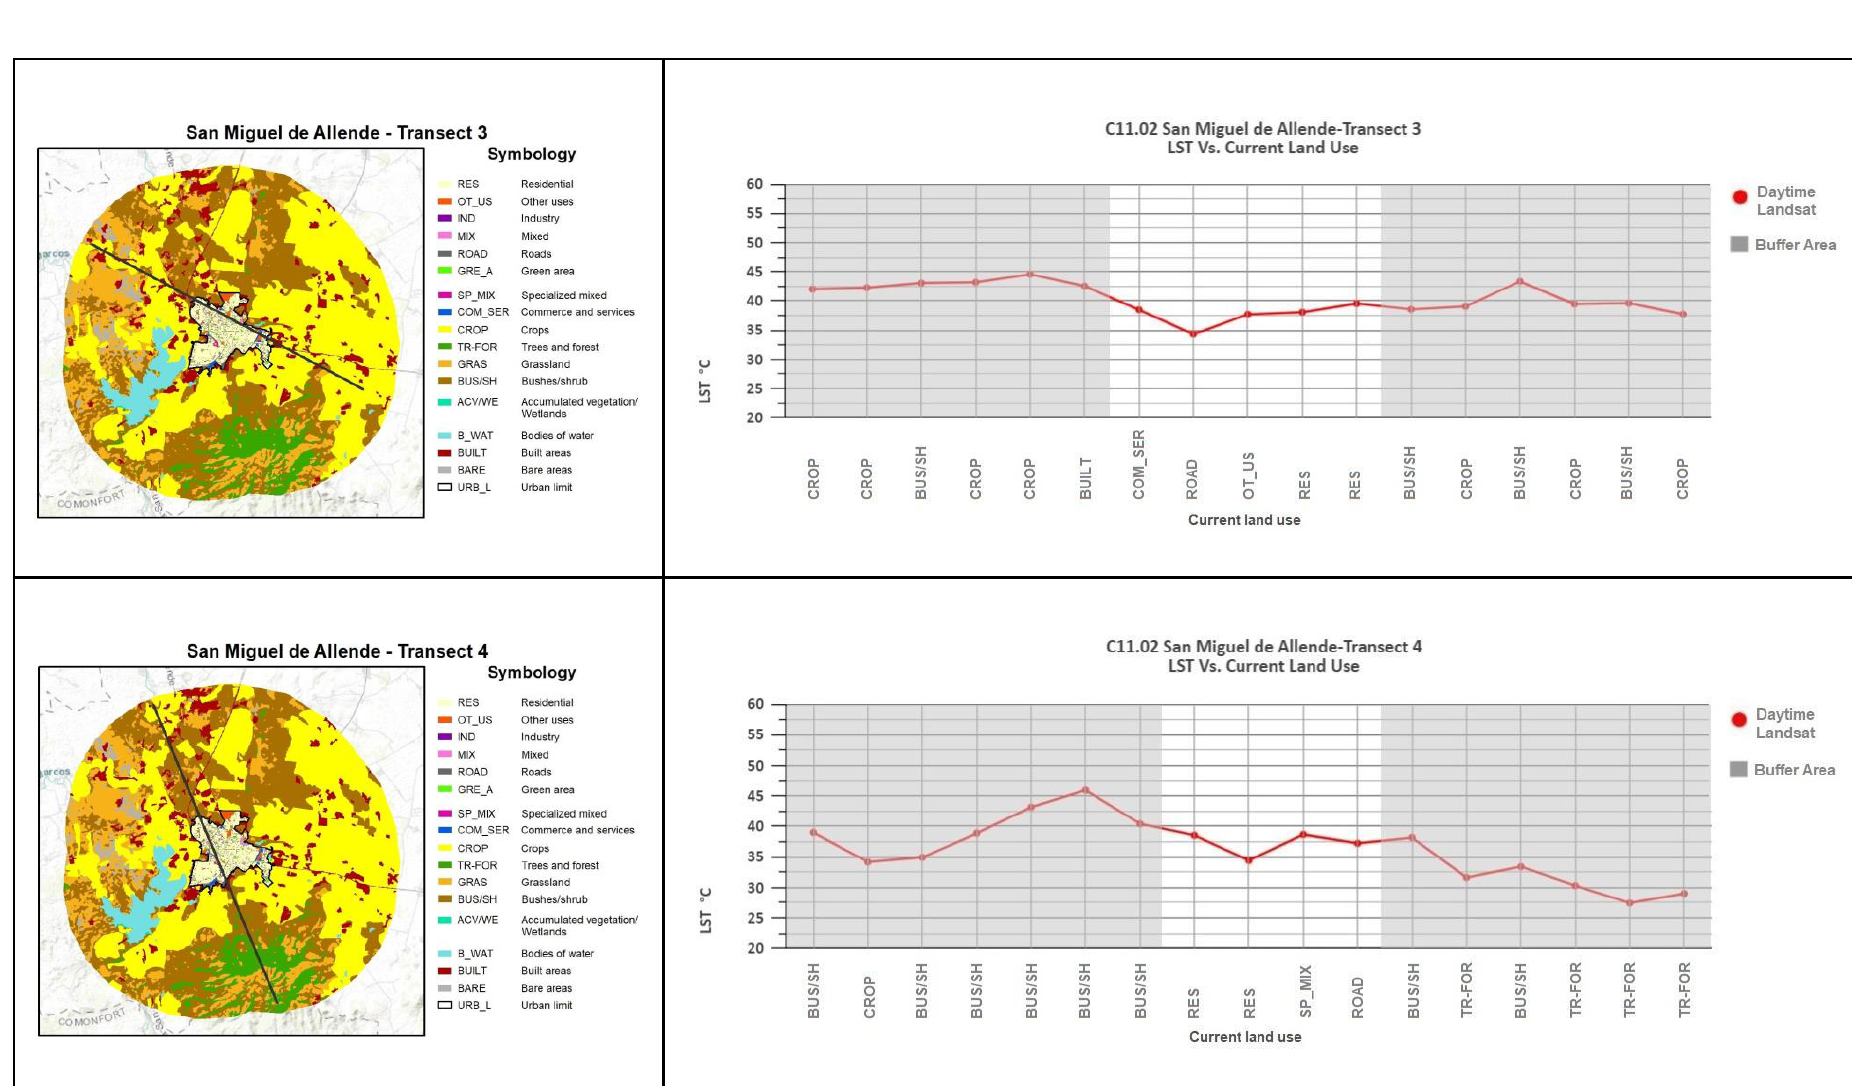
Figure 8. : Transects of San Miguel de Allende conurbated city. Figure 8. Transects of San Miguel de Allende conurbated